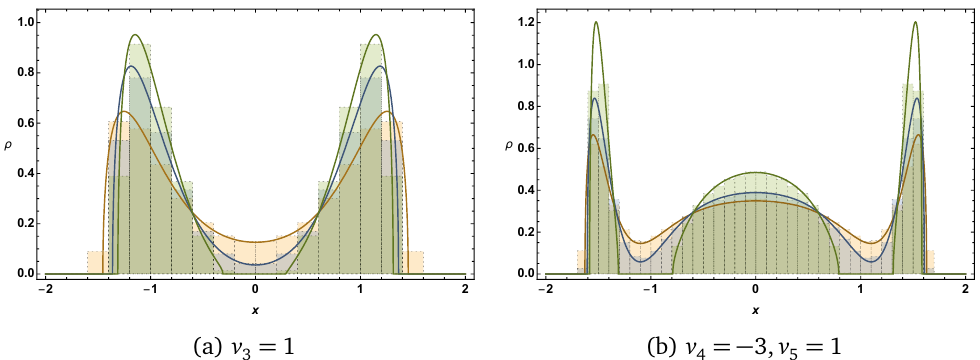
Figure 2: Distribution of singular values for two large N matrix Ising models. His- tograms are from Monte Carlo simulations of the matrix Ising model. Solid lines are analytically computed distributions from the corresponding matrix integral. For = 2.11 and the distribution is shown the model considered in the left plot (a), T c = 9.52 and the temperature shown are at T = 5,2.6,1.8. For the right plot (b), T c T =